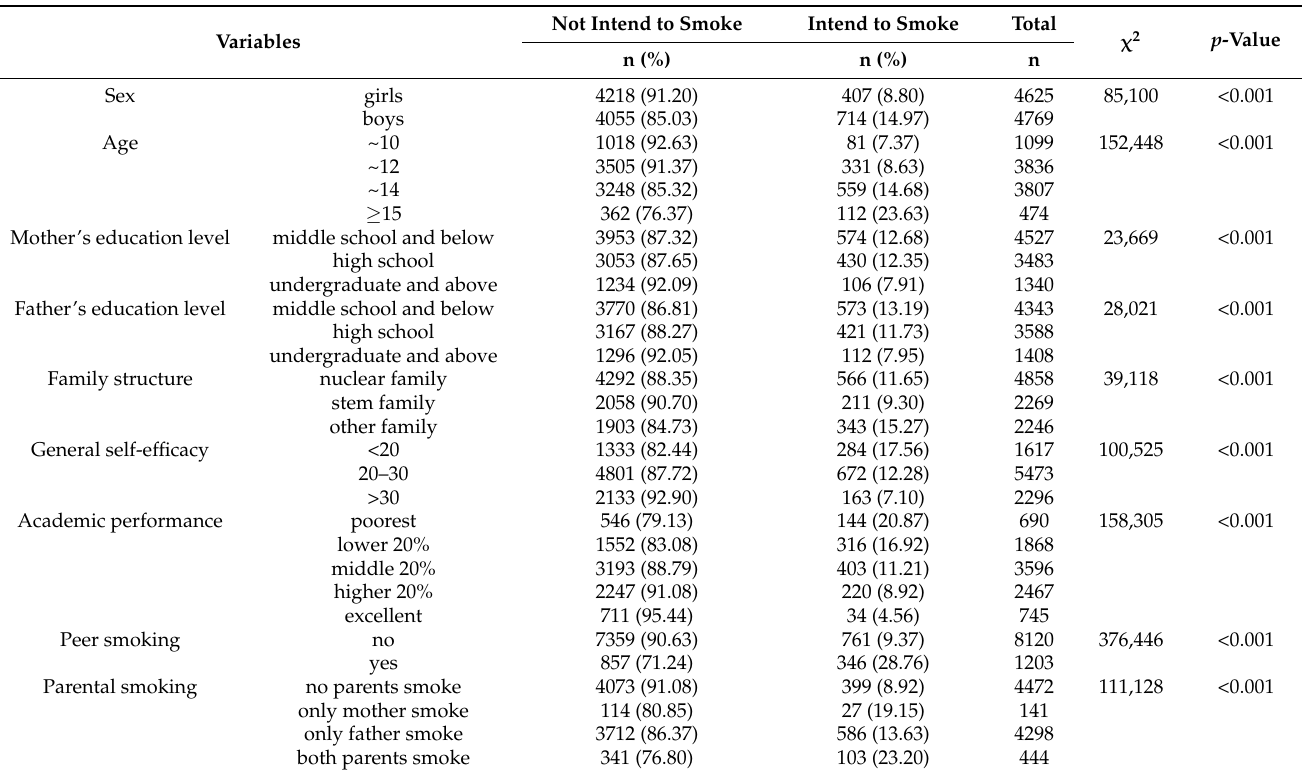
Table 1. Participant characteristics among students who are